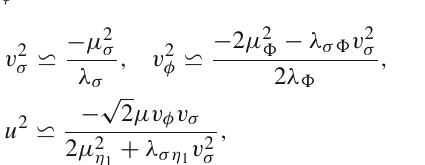
Fig. 1 Charged lepton mass